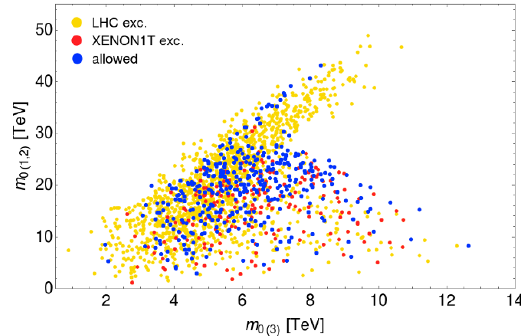
Figure 7. Locus of n = 1 landscape scan points for the NUHM3 model in the m 0 (1 ; 2) vs. m 0 (3) plane for (cid:22) = 100{360